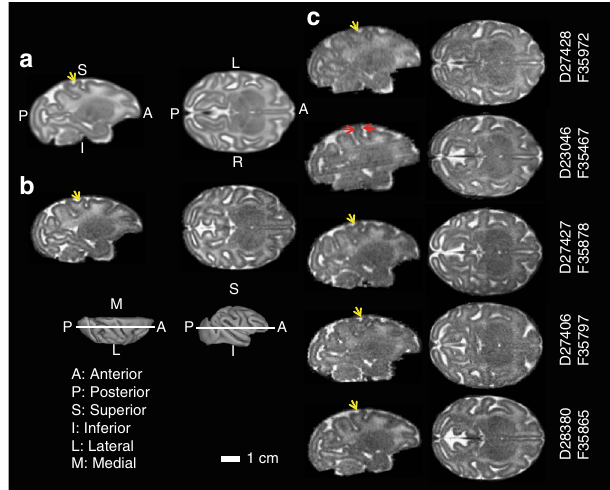
Fig. 6 Magnetic resonance imaging of fetal brains. A T2W brain template generated from 16 control fetuses at gestation age 135dGA ± 2d ( a ), a typical control at 135dGA ( b ), and the 5 ZIKV-exposed fetal brains ( c ) are shown in sagittal (left) and axial (right) views at the indicated slice locations (insets). Anterior/posterior, superior/inferior, lateral/medial, and left/right are marked on the 3D brain surfaces (insets) and template images ( a ). Despite the absence of microcephaly, a thinner somatosensory gyrus ( c , red arrows), and a missing secondary sulcus ( a – c , yellow arrows), was identi fi ed for animal F35467, but not other ZIKV-infected animals